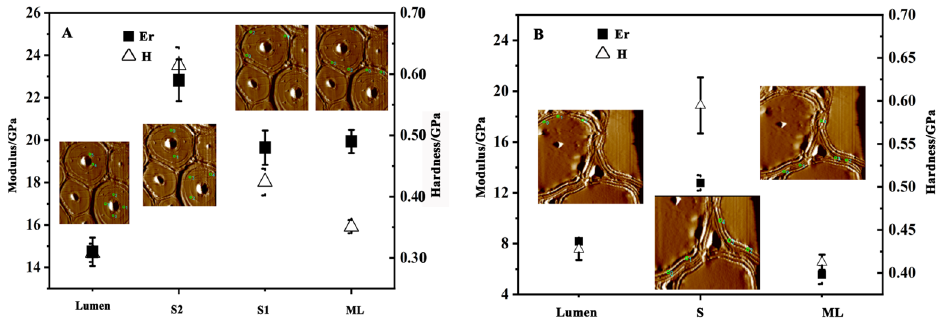
Figure 4. Nanoindentation and modulus mapping tests in the fiber cells ( A ) and parenchymal cells ( B